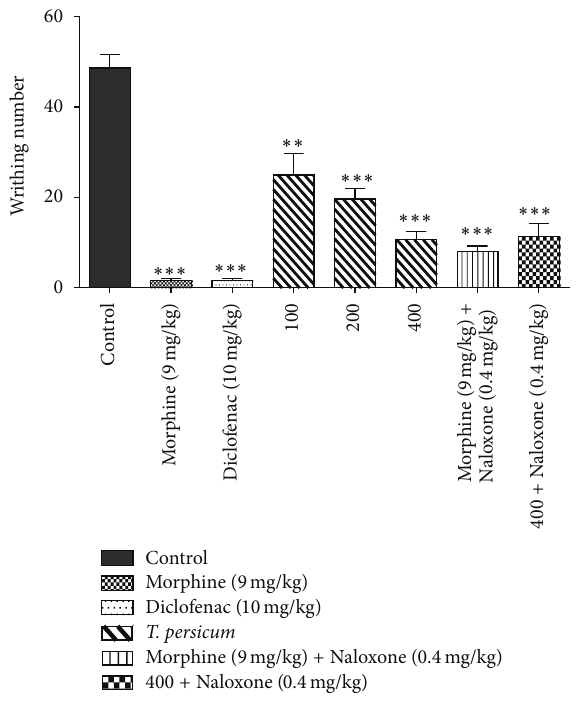
Figure 3: Analgesic effect of TPE in writhing test. ∗ 𝑃 < 0.05 , ∗∗ 𝑃 < 0.01 , and ∗∗∗ 𝑃 < 0.001 significantly different from the control animals. Each value represents the mean ± SEM ( 𝑛 = 8